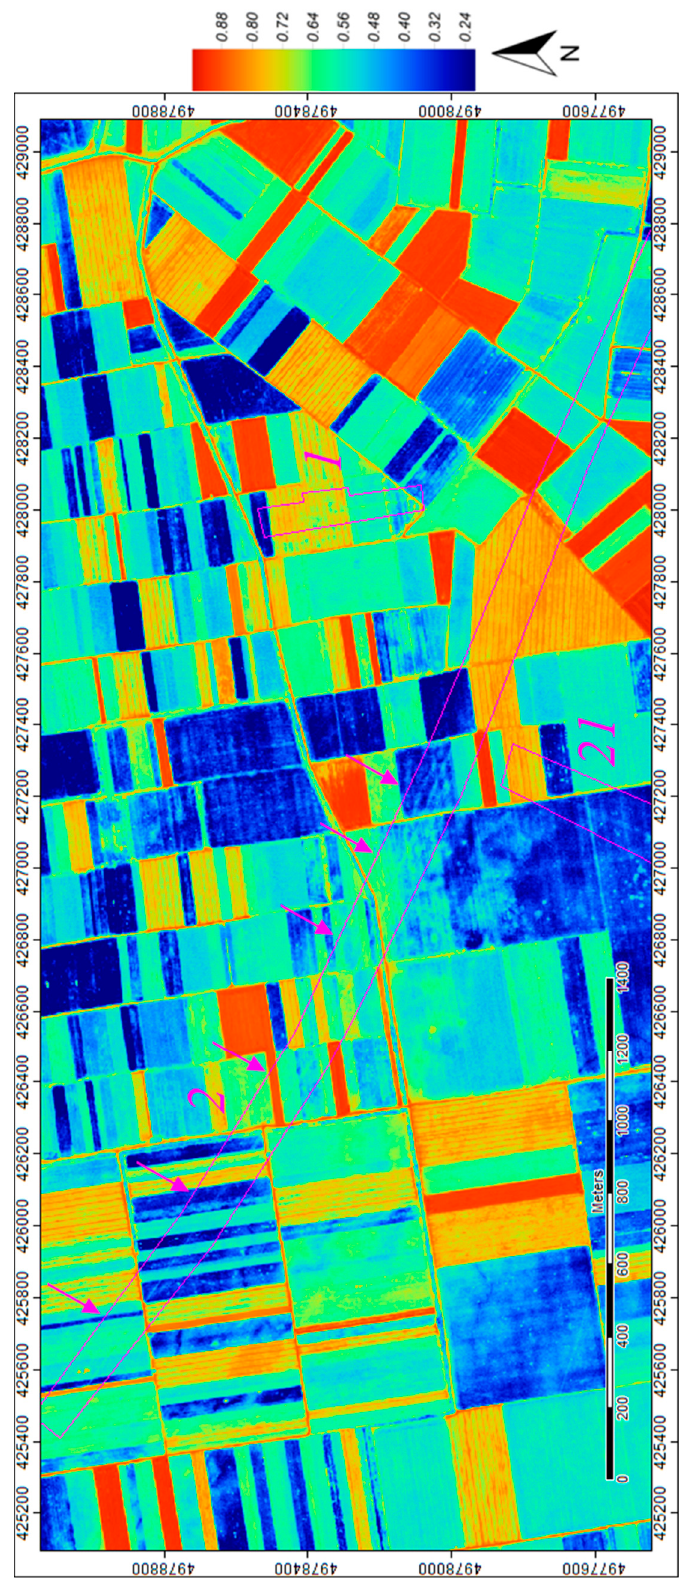
Figure 8. Output details for CC3_DR application to the WorldView2 image. The crop-marks identifying the presence of the Roman road and other buried archaeological remains are marked in magenta. The arrows mark the best-defined traces of the road. Data provided by the European Space Agency. For a geographical reference, see the crop-marks identification numbers and locations in Figure 9.